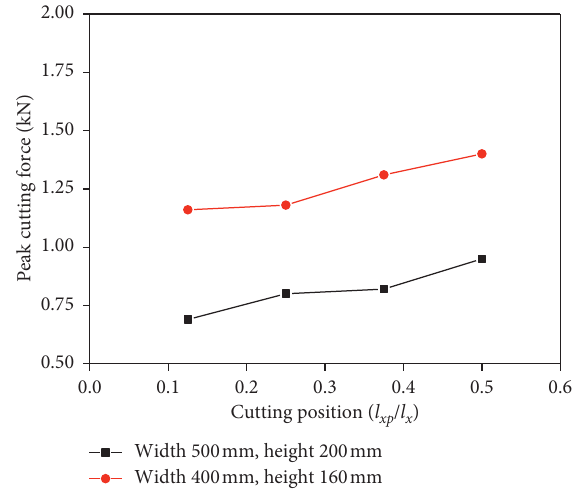
Figure 19: Variation in peak cutting force with cutting